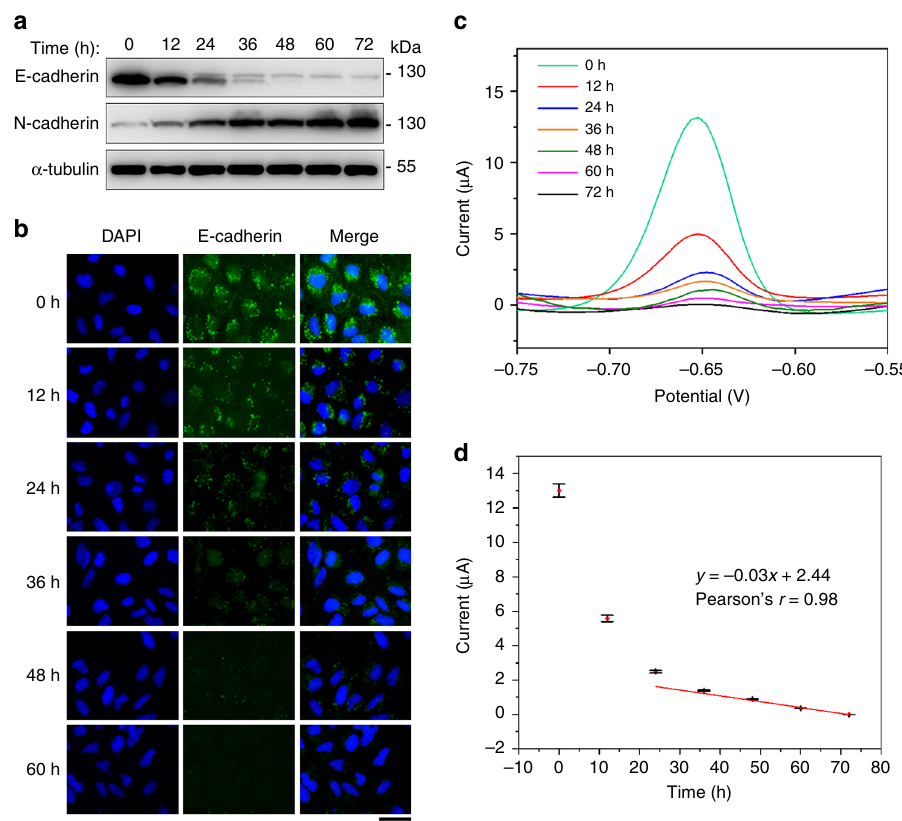
Fig. 5 Detection of different EMT stages with the electrochemical biosensor. a Immunoblotting of E-cadherin, N-cadherin, and α -tubulin in A549 cells treated with TGF for different time. b Examination of E-cadherin intensity in A549 cells upon TGF treatment by immuno fl uorescence microscopy. Scale bar, 40 μ m. c Electrochemical detection of different EMT stages using the biosensor by DPV. d Calibration curve showing the relationship between current and incubating time. Error bars represent ± s.d. ( n = 3). Source data are provided as a Source Data fi